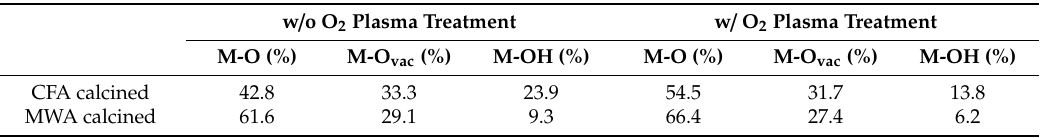
Table 2. Chemical compositions of electrospun CFA- and MWA-calcined IGZO NFs as determined before and after postcalcination oxygen plasma